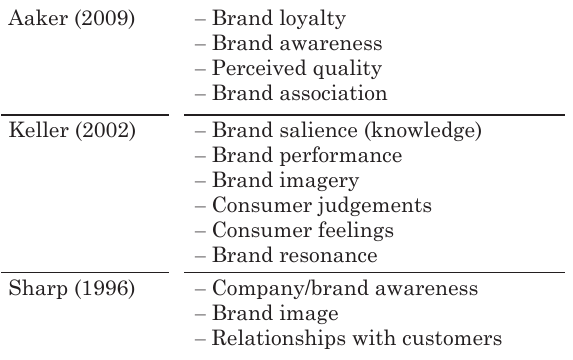
Table 1. Main constructs of consumer based brand